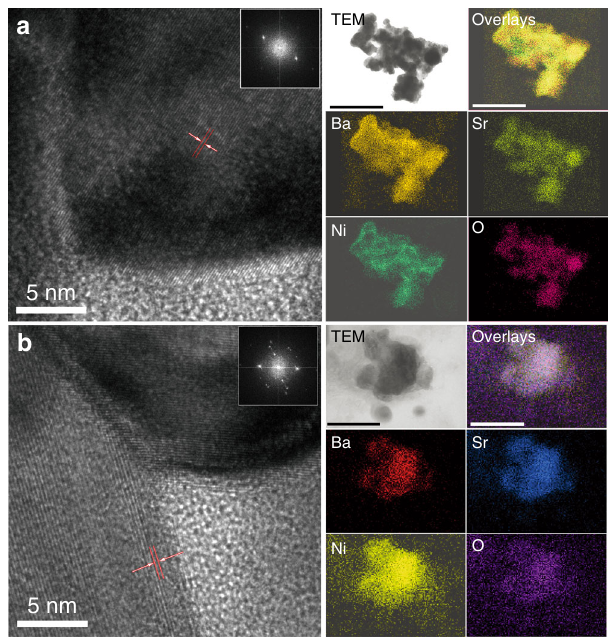
Fig. 5 Morphology measurements of Ba 0.75 Sr 0.25 NiO 3 before and after OER testing. a HRTEM before a stability test. b HRTEM after a stability test. Right side: STEM atomic mapping (scale bar: 500 nm). The labelled lattice spacing is around 0.3 nm, which corresponded to the (110) lattice planes of Ba 0.75 Sr 0.25 NiO 3 , in good agreement with the PXRD measurements. The insets of a , b show the fast Fourier transform image of the corresponding HRTEM image. The well-regulated arrayed spots indicated that the grown crystal had high crystallinity. HRTEM of Ba 0.75 Sr 0.25 NiO 3 before and after OER testing clearly showed the same lattice spacing and very similar fast Fourier transform images, suggesting outstanding stability of the Ba 0.75 Sr 0.25 NiO 3 sample under OER conditions. The maintenance of good crystallinity indicates that Ba 0.75 Sr 0.25 NiO 3 is a stable OER electrocatalyst. In order to verify the atomic distribution, STEM mapping was conducted; the even distribution of the atoms over the analyzed area further demonstrates the excellent stability of the